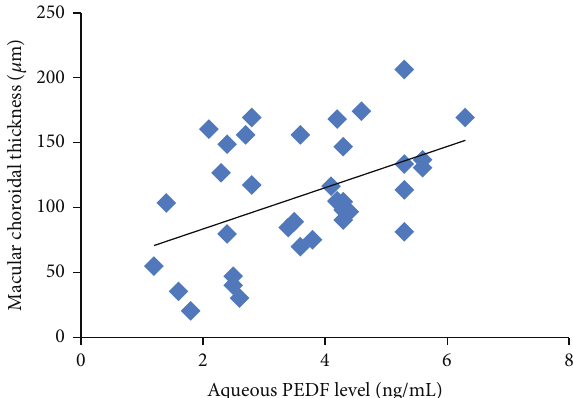
Figure 3: Scatterplots of aqueous PEDF levels and macular choroidal thickness in the non-CNV group show a significant positive correlation ( R 2 = 0.211; y = 15.852 x + 51.986; 𝑃 = 0.005 ).